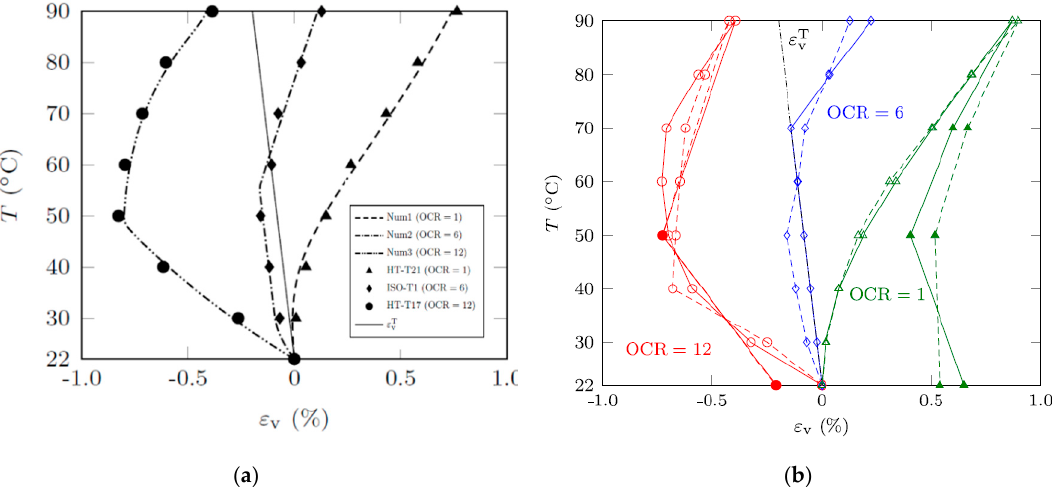
Figure 10. Volumetric deformations of Kaolin clay under isotropic drained conditions laboratory results (discontinuous lines) and numerical simulations ( a ) heating for three different OCR values [184], ( b ) results for OCR = 6 (heating) and for OCR = 1 and 12 (heating and cooling cycle) [164].